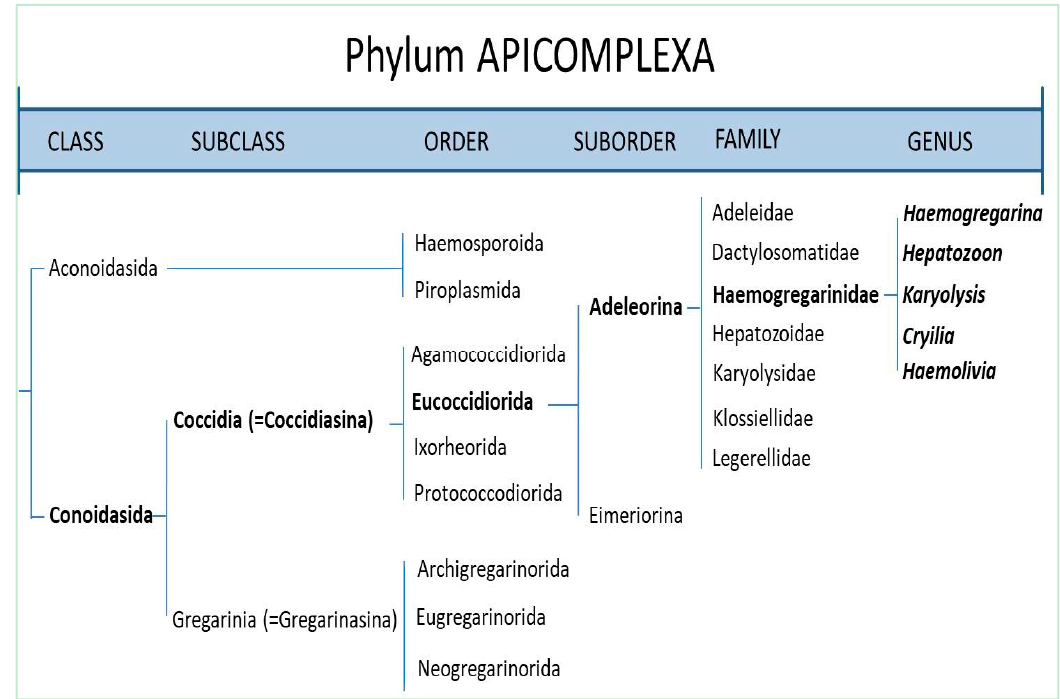
Figure 2. Haemogregarines as a part of phylum Apicomplexa.